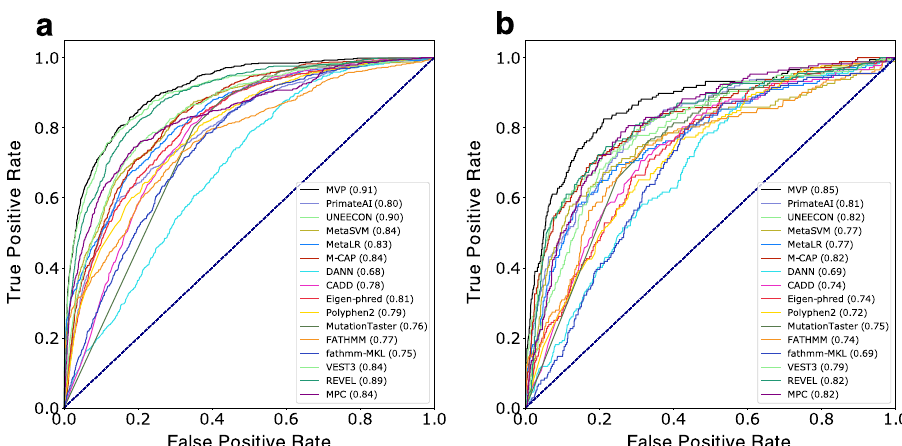
Fig. 1 Comparison of receiver operating characteristic (ROC) curves of existing prediction scores and MVP scores using cancer somatic mutation hotspot data. a Constrained genes (ExAC pLI ≥ 0.5): evaluation of 698 cancer mutations located in hotspots from 150 genes, and 6989 randomly selected mutations from DiscovEHR database excluding mutations used in training. b Non-constrained genes (ExAC pLI < 0.5): evaluation of 177 cancer mutations located in hotspots from 55 genes and 1782 randomly selected mutations from DiscovEHR database excluding mutations used in training. The performance of each method is evaluated by the ROC curve and area under the curve (AUC) indicated in parenthesis. Higher AUC score indicates better performance.